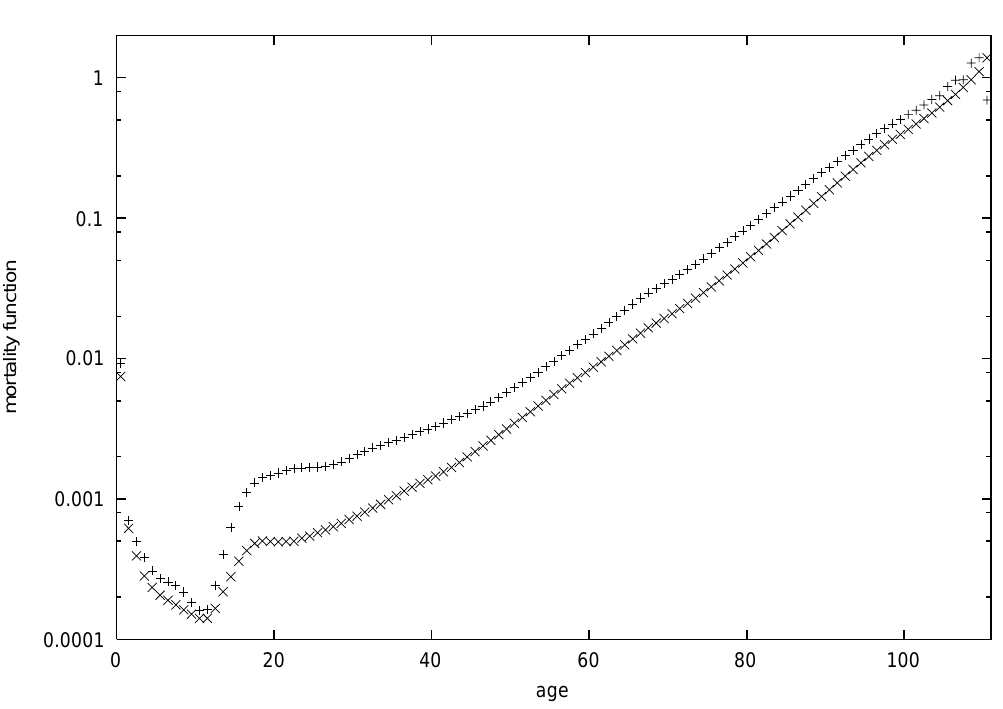
Fig. 1 – Male (+) and female (x) mortality functions in the USA, 1991-1995; from J.R. Wilmoth’s Berkeley Mortality Database demog.berkeley.edu/wilmoth/. The straight line through the male data indicates the expo- nential increase with age (Gompertz law). These mortality functions are defined as − d ln S(a)/da where S(a) is the probability to survive up to an age of a